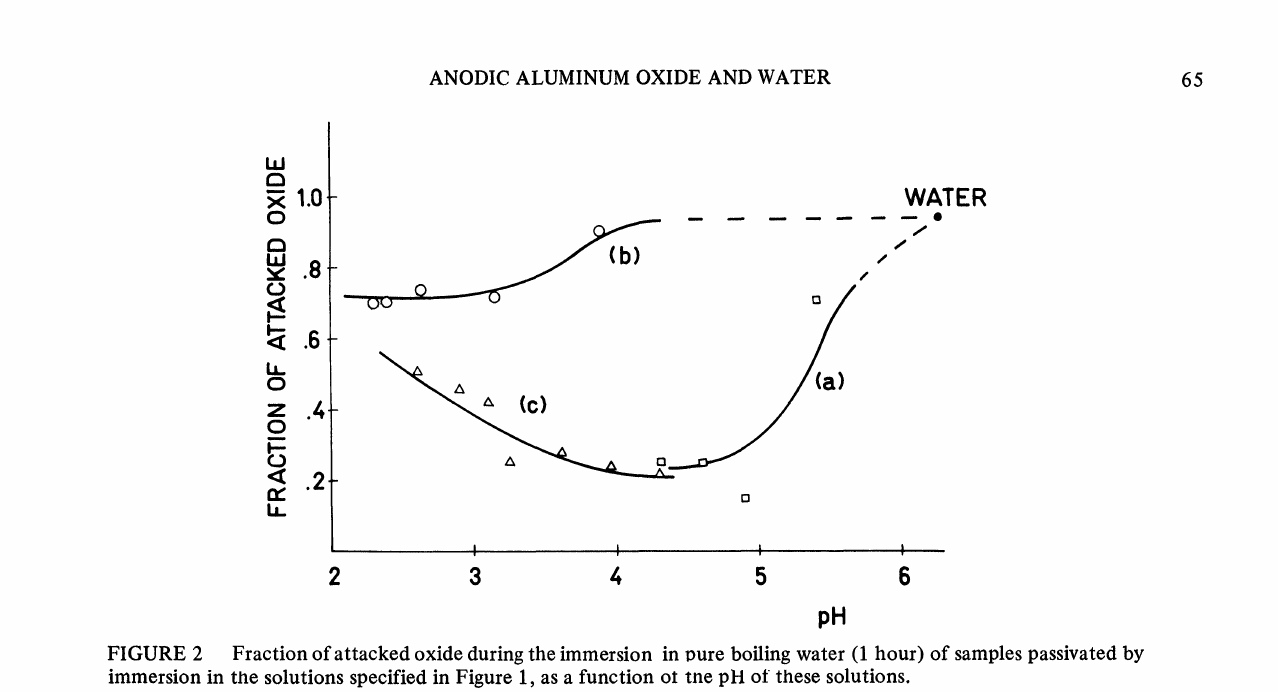
FIGURE 2 Fraction of attacked oxide during the immersion in oure boiling water (1 hour) of samples passivated by immersion in tlae solutions specified in Figure 1, as a function ot the pH or these